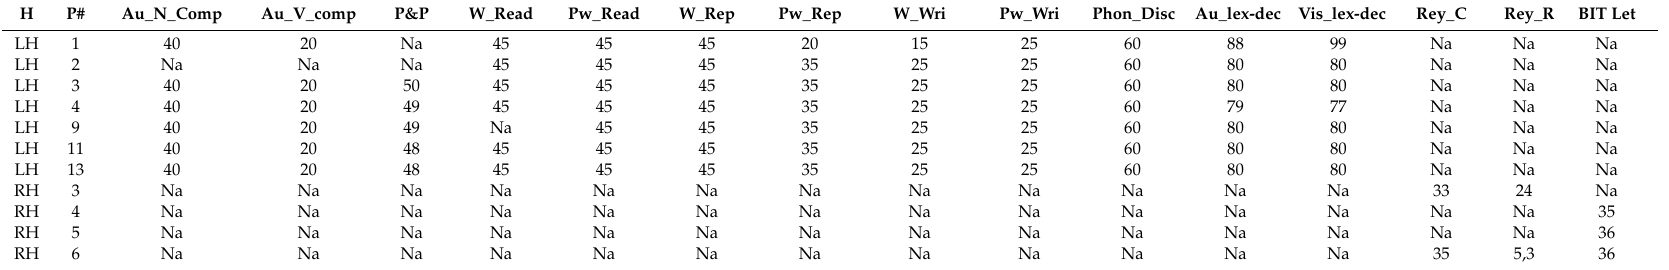
Table 4. LH and RH iLGG patients’ additional neuropsychological test, according to the lesion